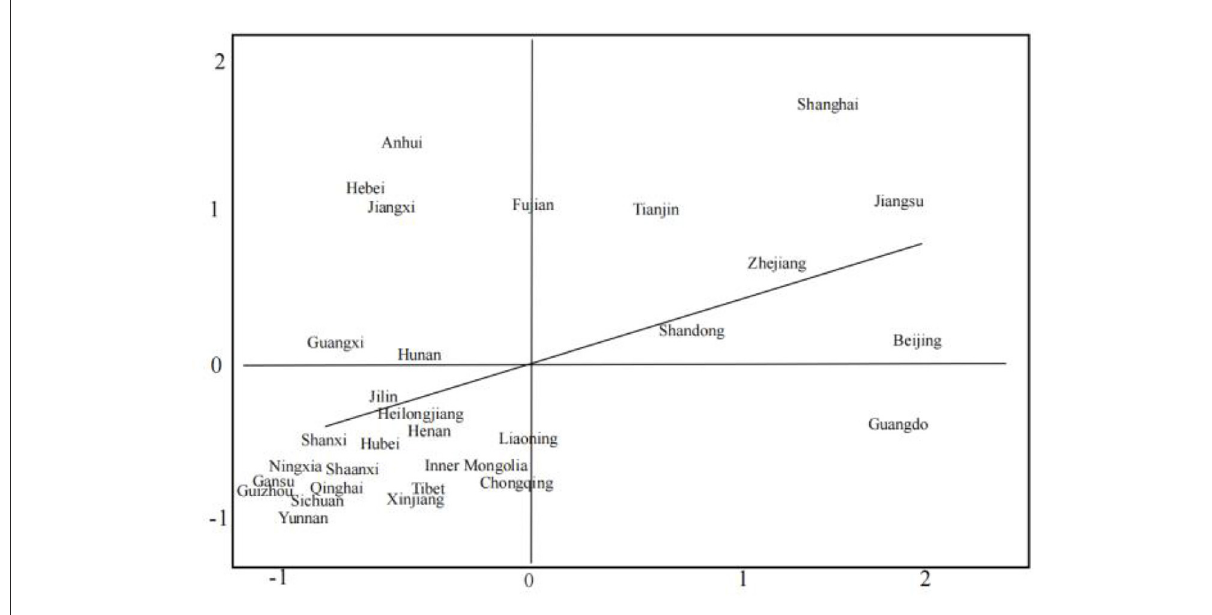
FIGURE2 Moran scatter plot.